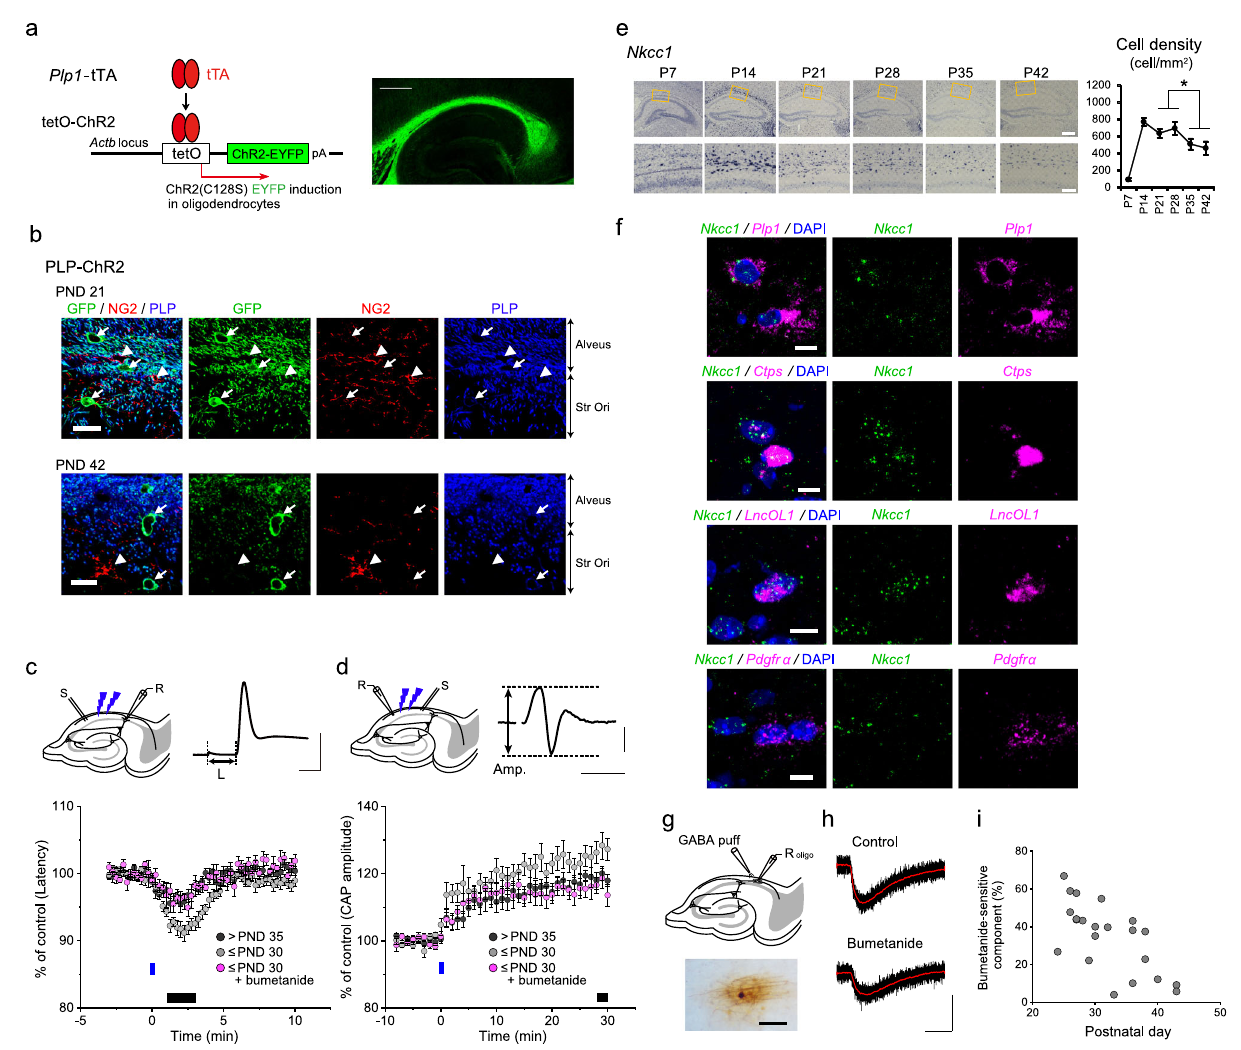
(ChR2) (C128S)-EYFP expression in the tetracycline system and fl uorescent image of the hippocampus labeled with an anti-GFP antibody. Scale bar,